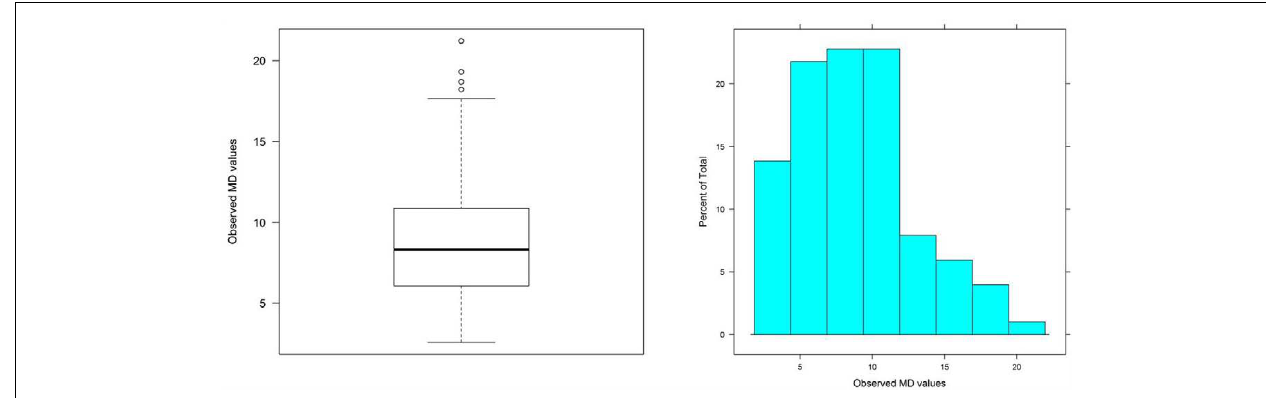
FIGURE 3 | Distribution of Mahalanobis Distance (MD) for multivariate normal random sample data ( N = 100; no unusual cases).